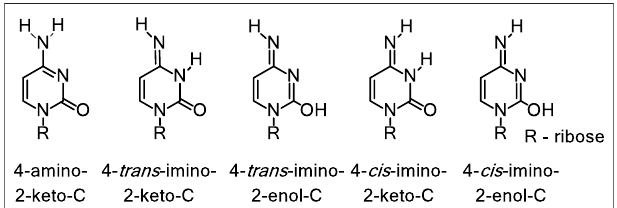
FIGURE 1 | Prototropic tautomerism in cytosine. Nucleic acid bases containketo,amino,orbothfunctionalgroups.Thesegroupsoftenparticipate in keto-enol and amino-imino tautomerism as shown here for the native base cytosine.